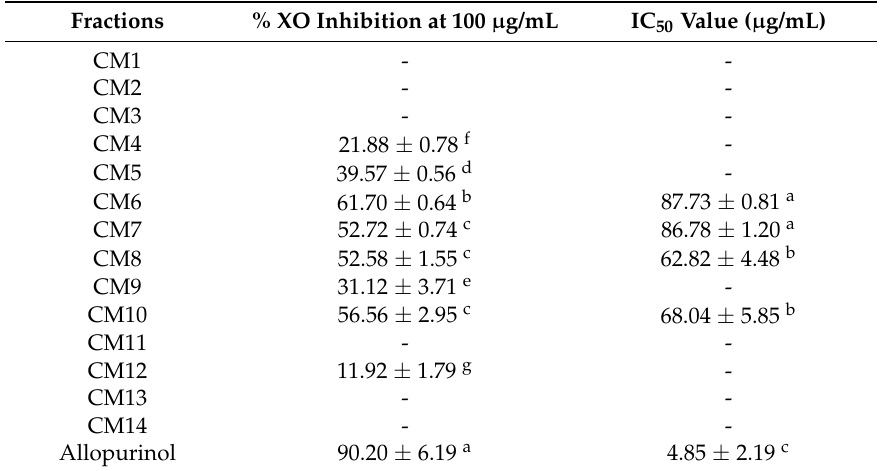
Table 2. Xanthine oxidase inhibitory activity of EtOAc fractions isolated from C. militaris .